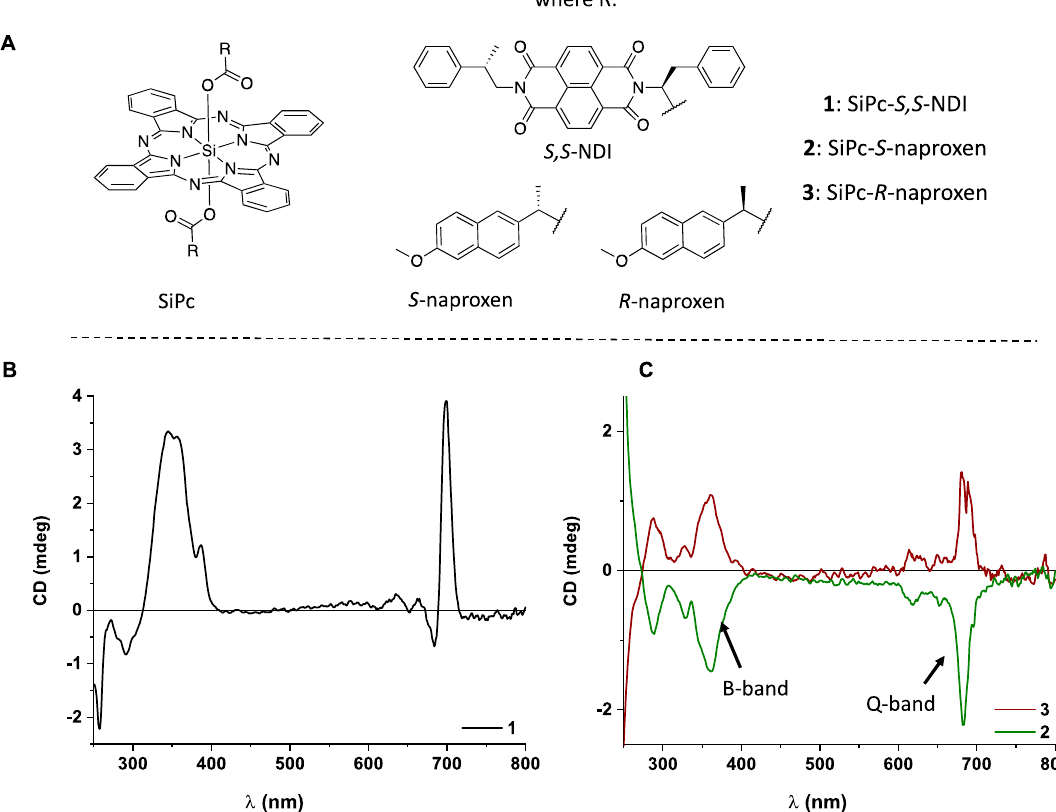
Figure 1. ( A ) Chemical structures of metallophthalocyanines (Pcs) used in this work; ( B ) electronic circular dichroism (ECD) spectrum of 1 (black line); ( C ) ECD spectra of 2 (green line) and 3 (brown line) solutions in CH 2 Cl 2 (2 × 10 − 5 M). The main spectral features B- and Q-bands of Pcs are shown in C [19].